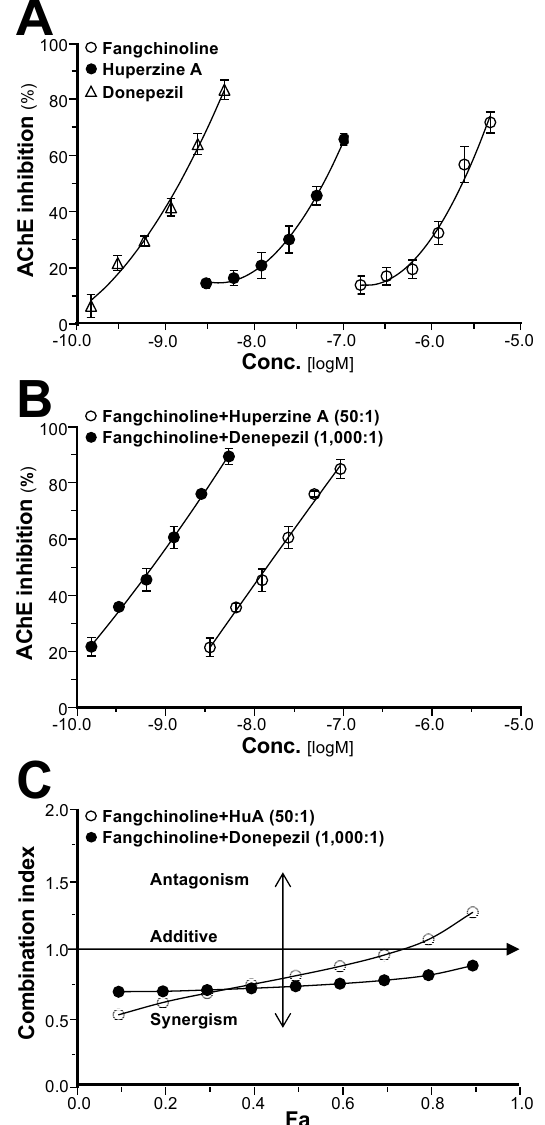
Figure 5. Synergy of fangchinoline and huperzine A or donepezil on AChE inhibition. ( A ) Fangchinoline (0.156–5 μ M), huperzine A (3.125–100 nM), and donepezine (0.156–5 nM) dose-dependently inhibited AChE. ( B ) Fangchinoline and huperzine A or donepezil dose-dependently inhibited AChE. Different doses of fangchinoline, huperzine A, donepezil, and fangchinoline–huperzine A or fangchinoline–donepezil combinations were added to the assay solution and preincubated at 37 °C with the brain lysate, followed by the addition of ATCh (0.625 mM). The absorbance of the assay solution at 405 nm was measured. The data were calculated as the percentage inhibition, and the results are expressed as the mean ± SEM (standard error of mean) of three dependent assays, each with triplicate samples. ( C ) Synergism analysis of fangchinoline and huperzine A or donepezil evaluated by the median-effect principle. The combination index (CI) values of these combinations were calculated as described in Section 4. The F a –CI plots of fangchinoline and huperzine A or donepezil are demonstrated. Values of CI < 1, CI = 1, and CI > 1 refer to synergistic, additive, and antagonistic e ff ects,